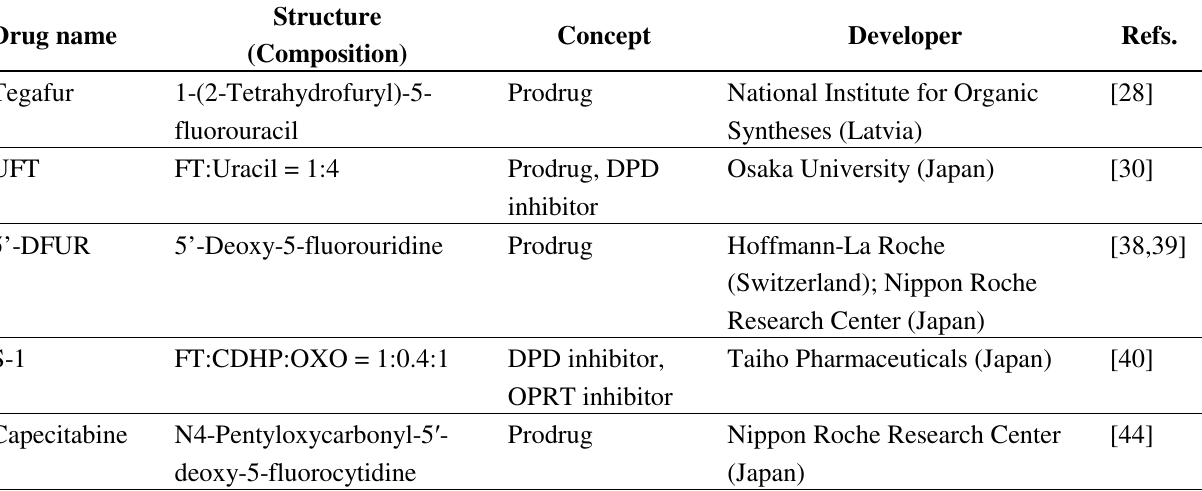
Table 1. Orally-administrable 5-FU drugs.